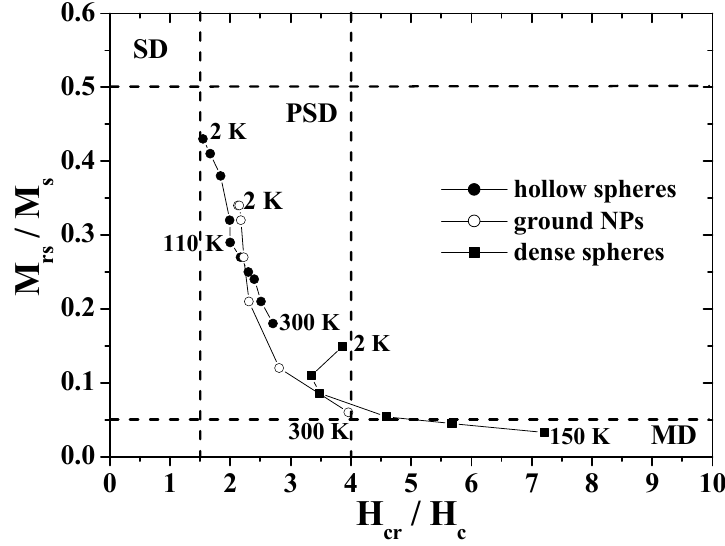
Figure 9. The Day plots of M ground